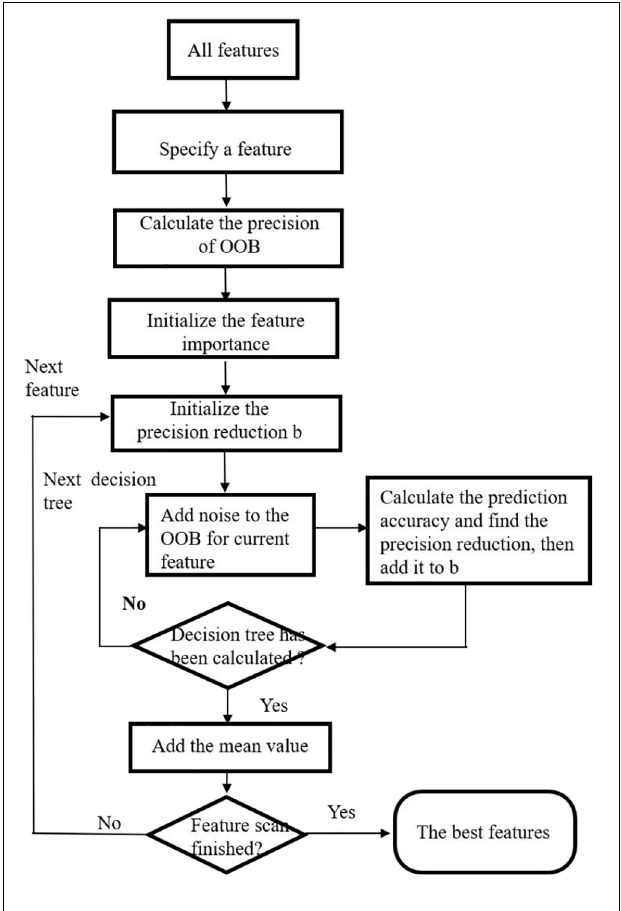
FIGURE 2 | Flow chart of feature selection using extremely randomized tree (Extra